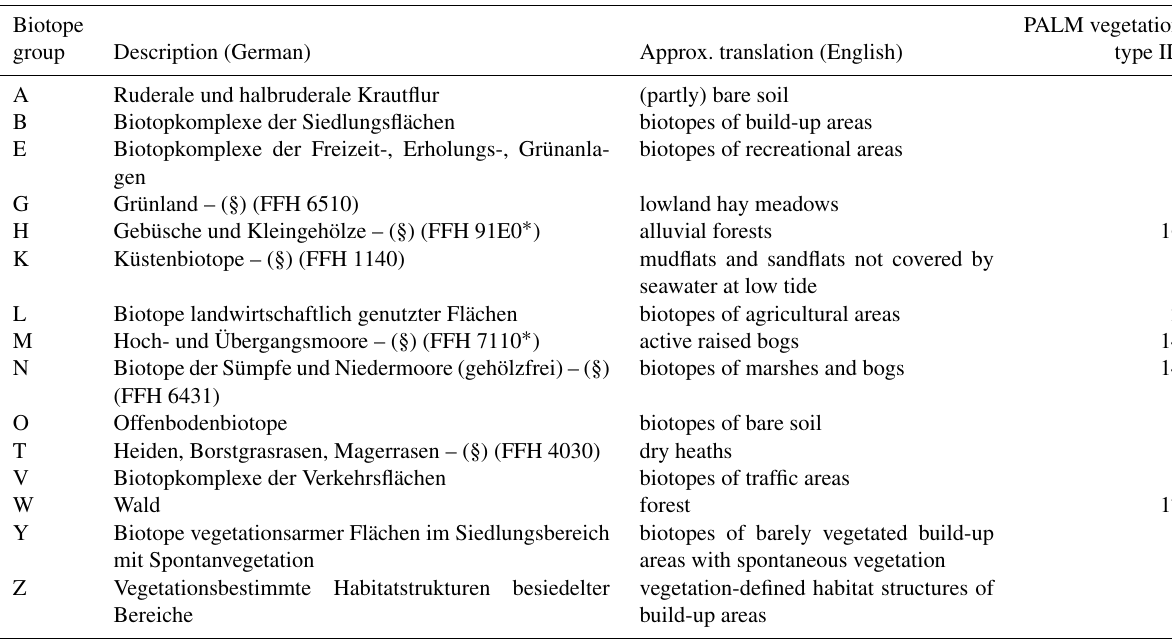
Table B3. Biotope type groups of the biotope map Hamburg to PALM vegetation type. Biotope